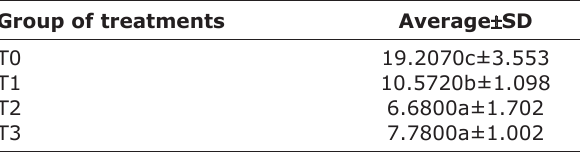
Table-4: Means of percentages of spermatozoa abnormalities. Group of